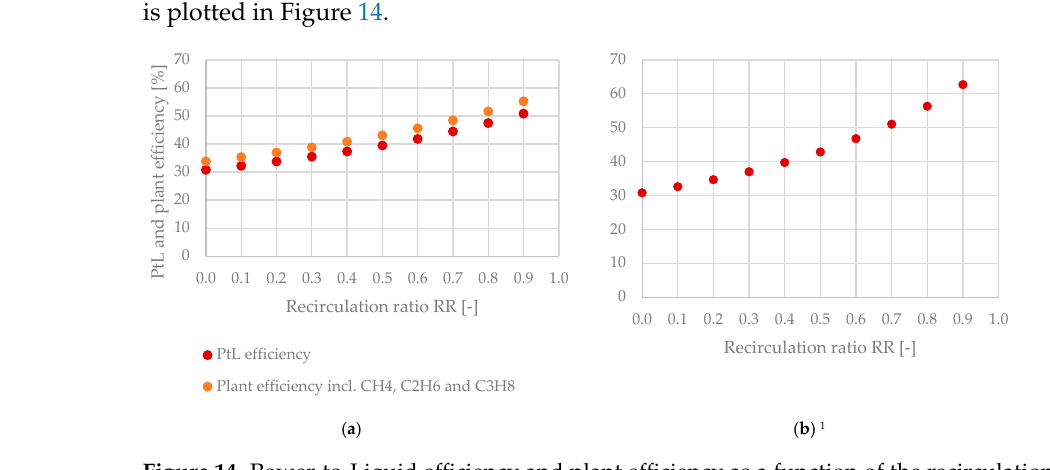
Figure 14. Power-to-Liquid efficiency and plant efficiency as a function of the recirculation ratio— ( a ) without tail gas reforming, ( b ) with tail gas reforming. 1 η PtL and η Plant are equal due to the combustion of the purge gas stream.